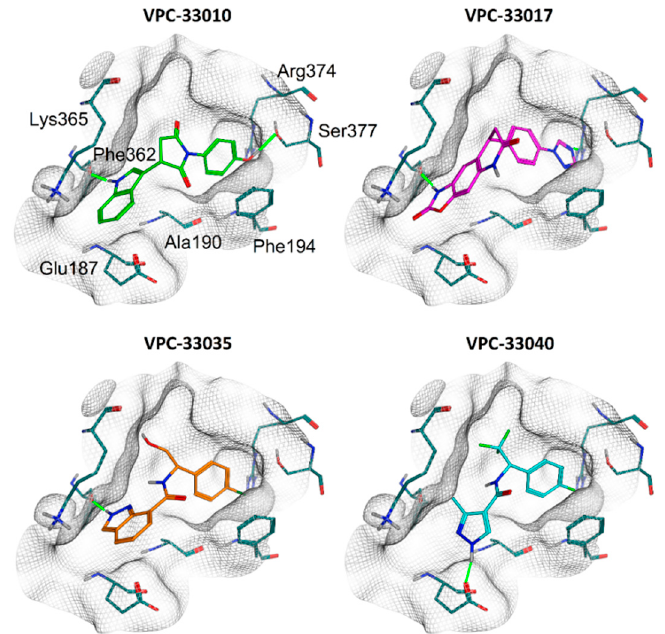
Figure 3. Predicted binding modes of identified compounds in Atro-box binding pocket of TLX LBD. The grids represent pocket surface. Hydrogen bonds are colored green. Only residues forming directed interactions with small molecules are shown.